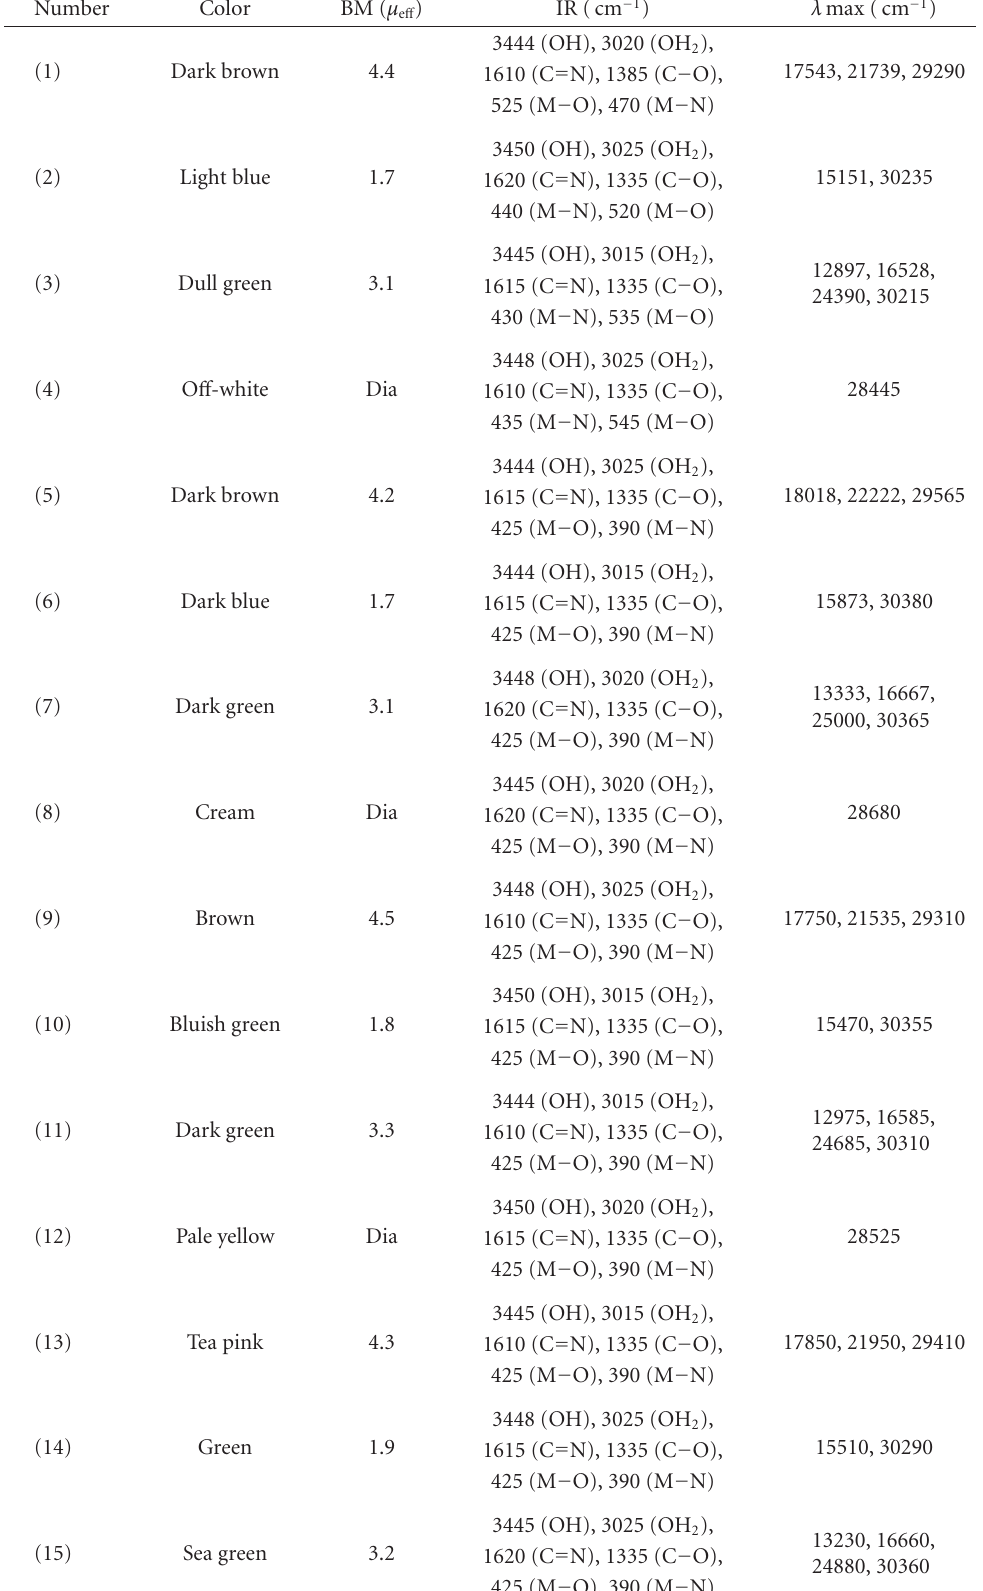
Table 2: Physical and spectral data of the metal(II) complexes